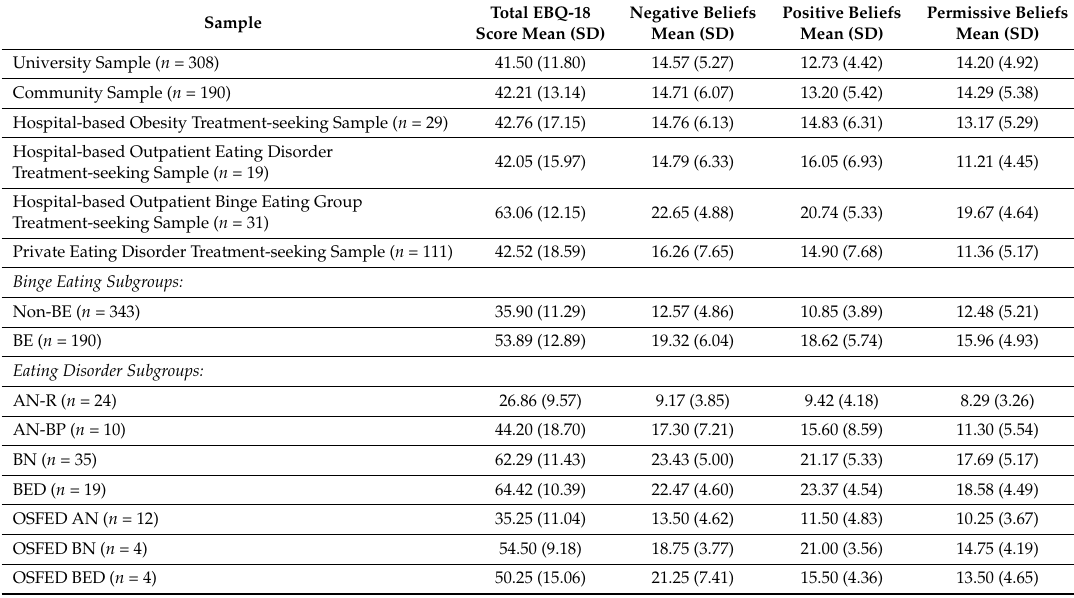
Table 5. EBQ-18 Subscale means and SDs for different sample groups.